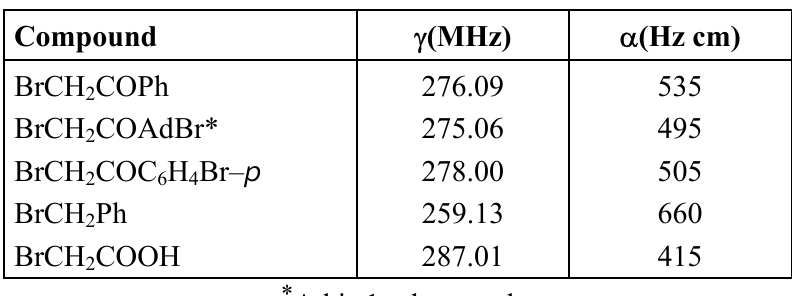
R Derivatives 2